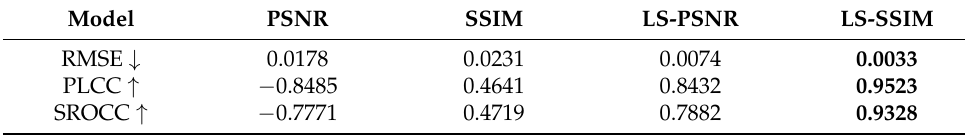
Table 1. RMSE, PLCC, and SROCC results of different R IQA models. Best results bold.